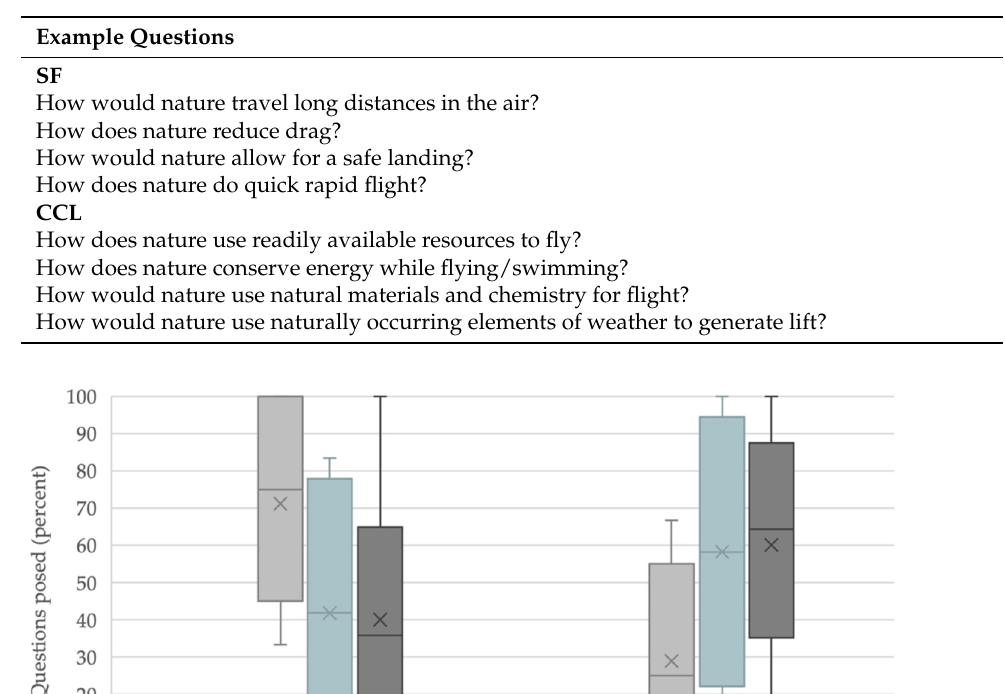
Table 1. Student design sprint question response examples and Structure-Function (SF) and Condi- tions Conducive to Life (CCL) classifications.